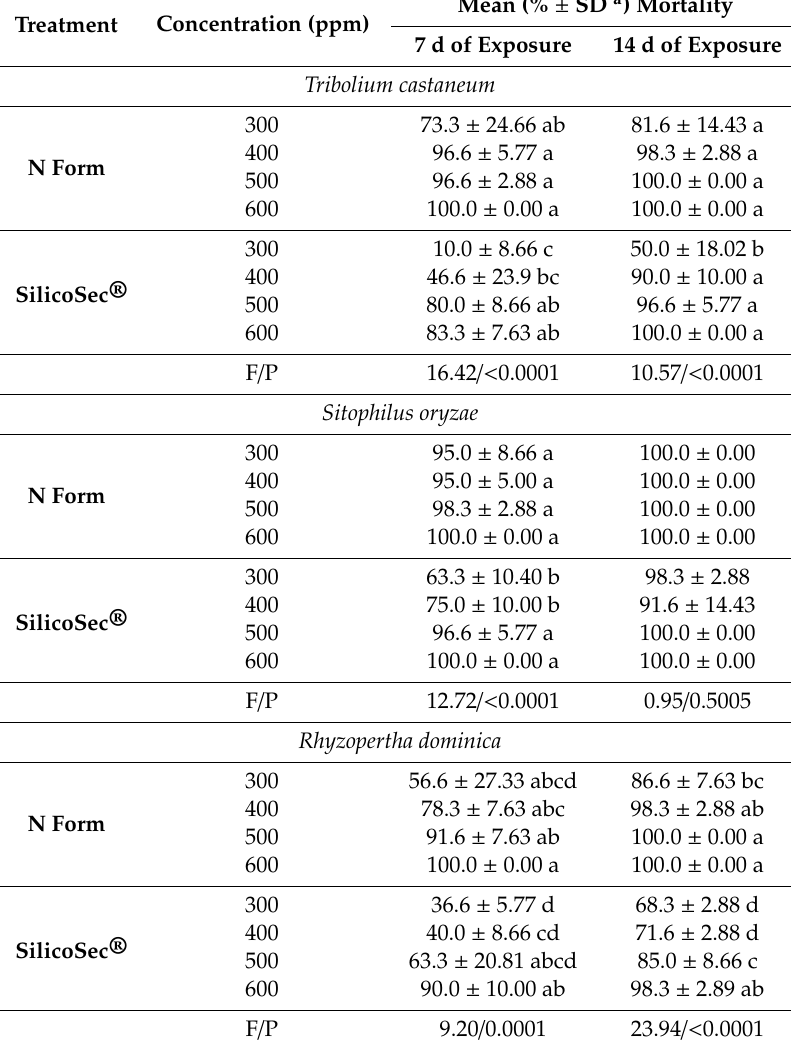
Table 2. Mean (% ± SD) mortality of Tribolium castaneum, Sitophilus oryzae, and Rhyzopertha dominica adults after 7 and 14 d of exposure to treated barley seeds with formulation N Form and DE SilicoSec ®